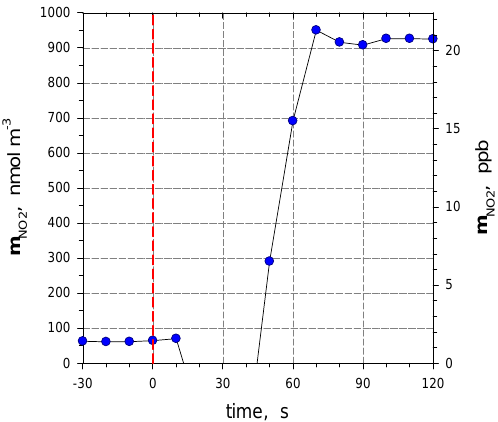
Fig. 7. Response test for step changes between two different NO 2 Figure 7. Response test for step changes between two different NO 2 concentrations ( m NO2 ). 3 The red dashed line marks the switching point. Note: negative values resulted in delayed 4 concentrations ( m NO ). The red dashed line marks the switching 2 internal compensation process for temperature and pressure of the analyzer after switching. 5 point. Note: negative values resulted in delayed internal compen- 6 sation process for temperature and pressure of the analyzer after